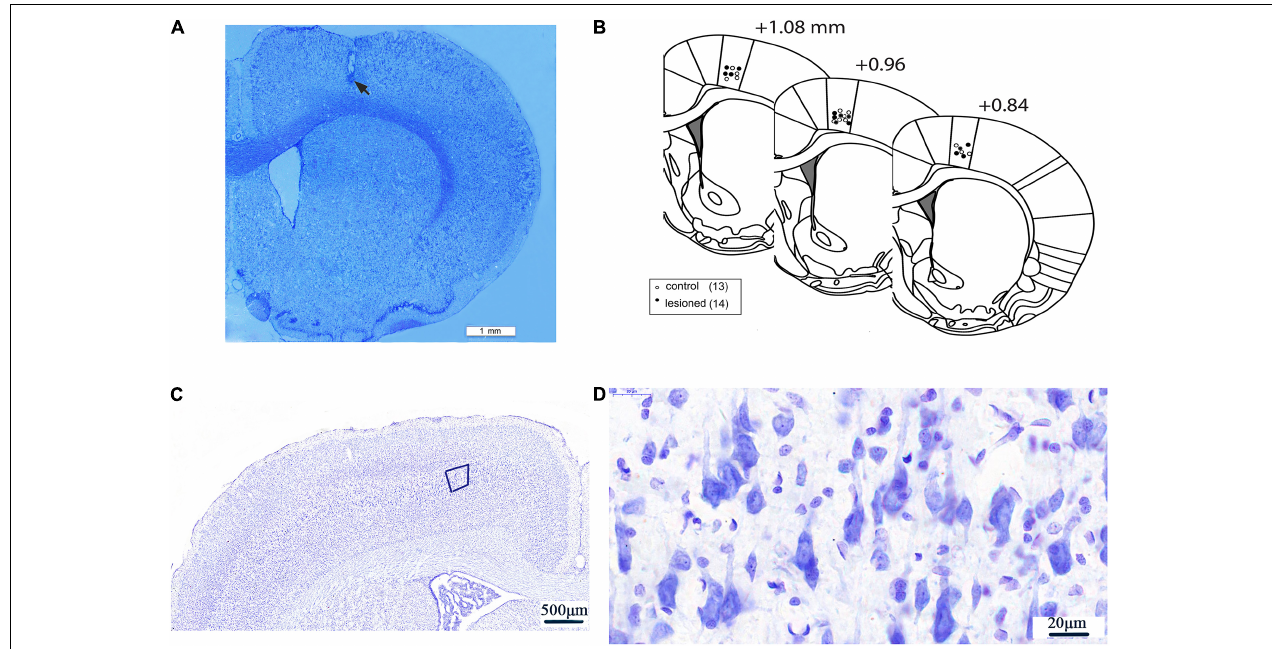
FIGURE 2 | Electrode recording sites and neurons in layer 5 of M1. An example of low magnification (20 × ) coronal section of a rat brain displaying the histological verification of the recording electrode tip at layer V of the M1 by Nissl staining. Scale bar = 1 mm. The electrode tip was marked by electrolytic lesion (black arrow) (A) . Three schematic drawings of the rat coronal brain sections were adapted from the rat brain atlas (Paxinos and Watson, 2007), indicating the recording electrode sites in the M1 of 6-OHDA-treated rats (black circles) and control rats (white circles) (B) . Neurons in Layer 5 of M1) (50 × ) (C) . The magnification of the fifth layer of M1) (1250 × ) (D)